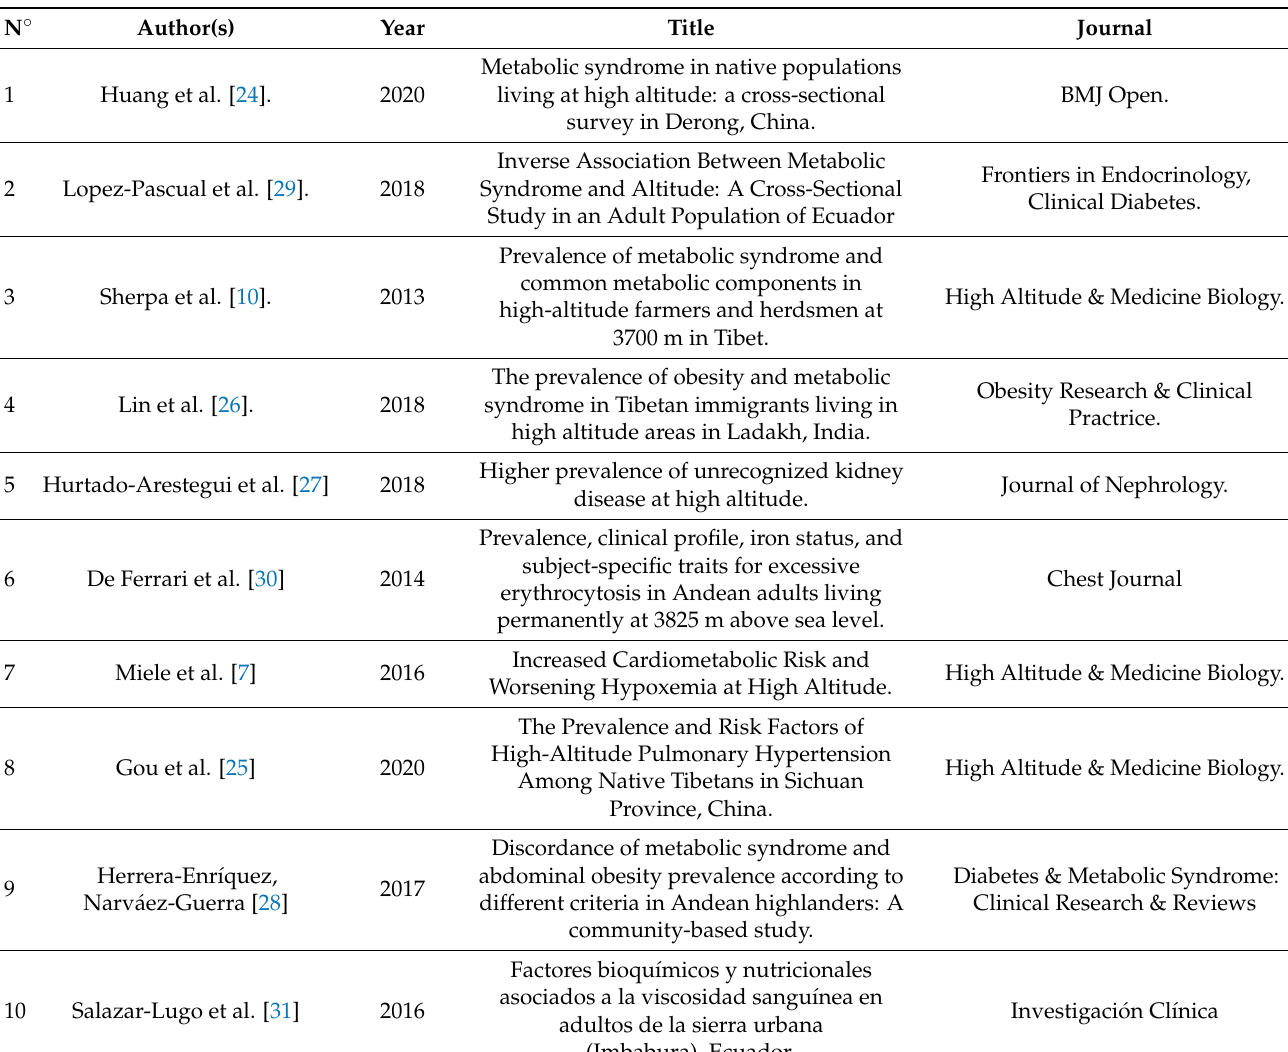
Table 2. Indicators of the articles systematized for the